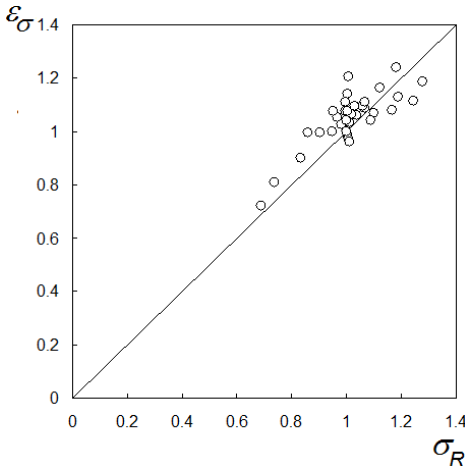
Figure 5. Relative standard deviation of annual river runoff ε σ ver- sus relative value of climatic runoff ε R .